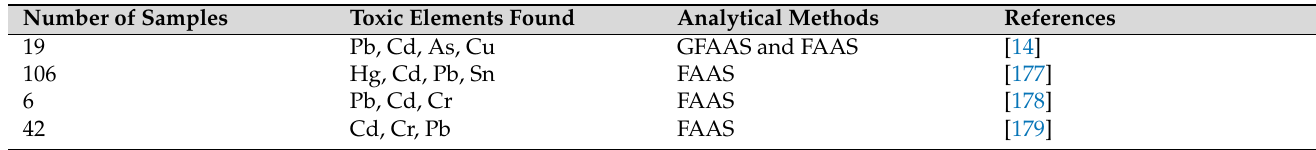
Table 5. Brazilian propolis toxic metals